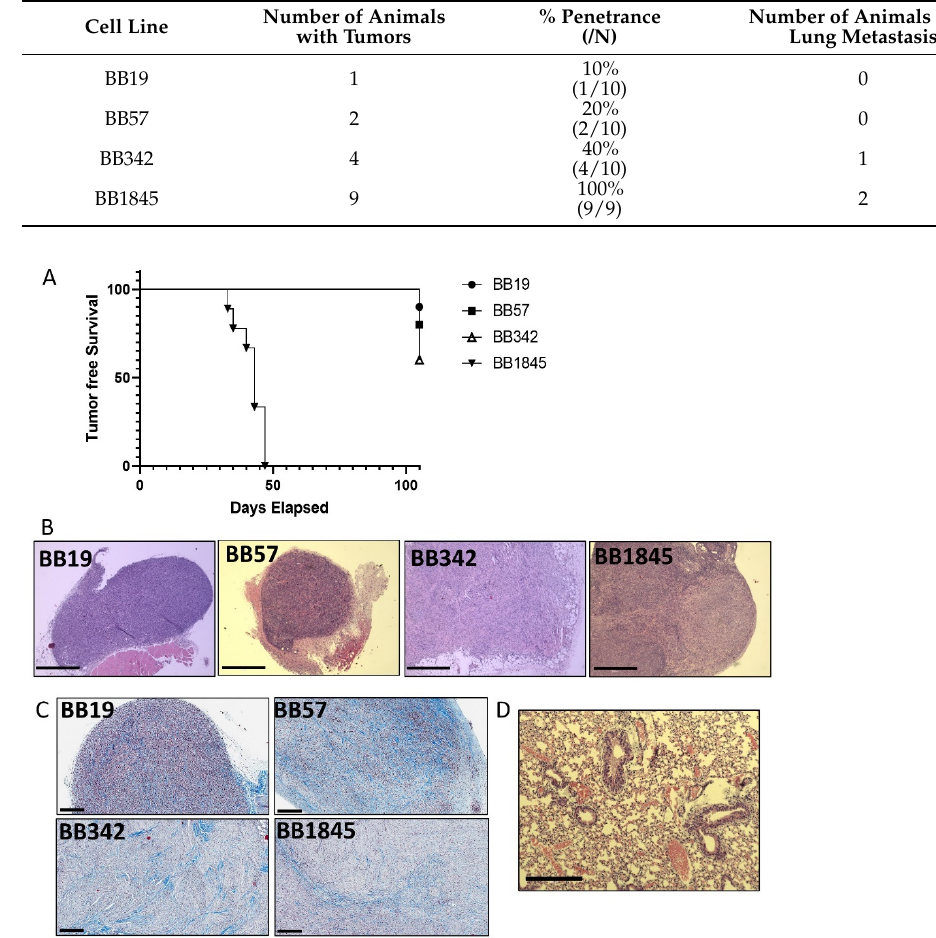
Table 2. Summary of tumor penetrance and lung metastasis of injected cell lines.